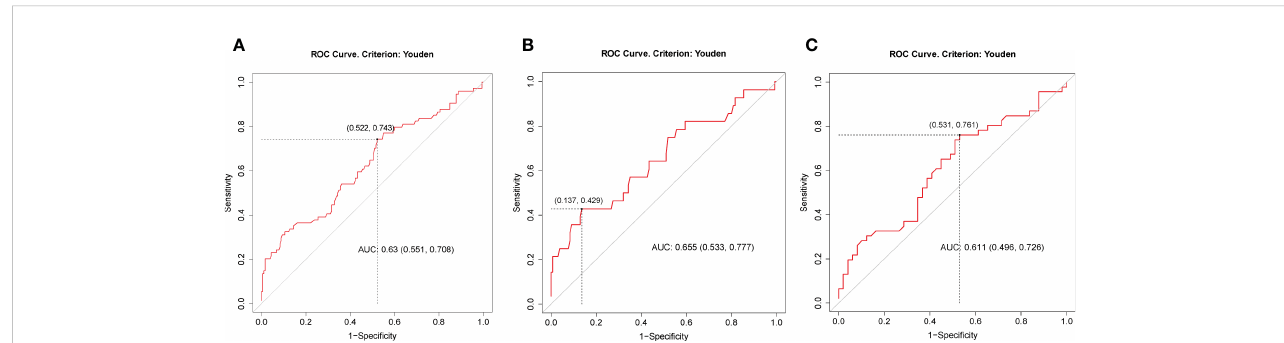
FIGURE 2 ROC curves for preoperative TSH as a predictor of gastrointestinal side effects of liraglutide among all patients (A) , males (B) and females (C) . The best cutoff points in (A, B, C) were 1.37 (speci fi city = 0.48, sensitivity = 0.74), 2.30 (speci fi city = 0.86, sensitivity = 0.43) and 1.33 (speci fi city = 0.47, sensitivity = 0.76), respectively. AUC, area under the ROC